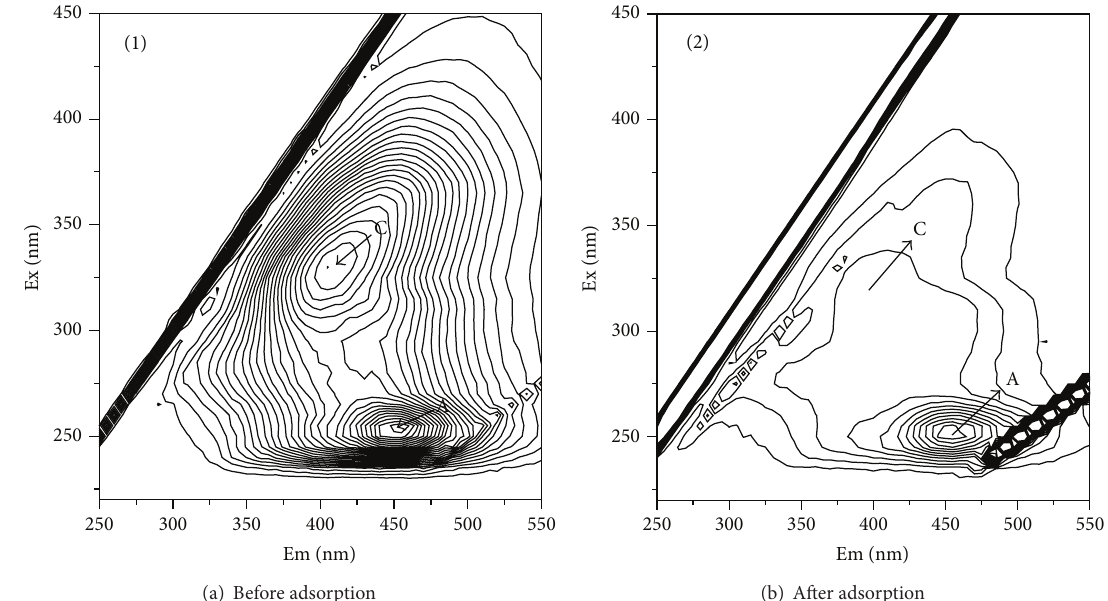
Figure 9: 3DEEM for dissolved organic matters of leachate biochemical treatment effluent.